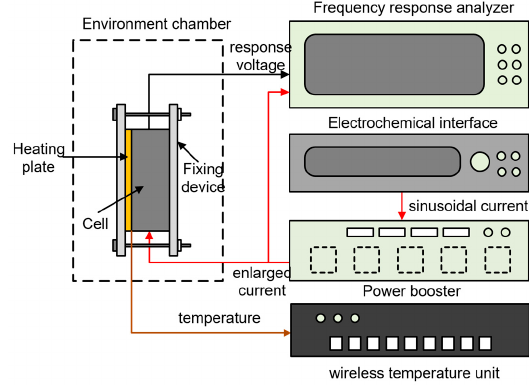
Figure 9. Diagram of battery EIS experiment with the temperature gradients.